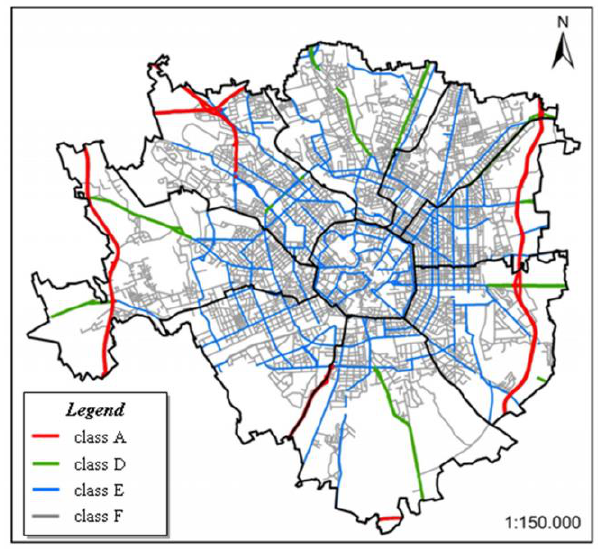
Figure 2. The spatial distribution of road types in the urban area of Milan, Italy.